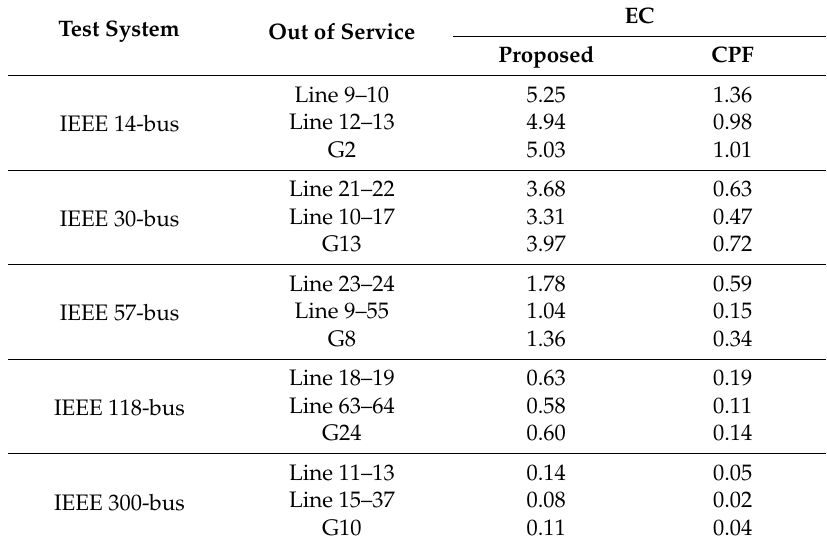
Table 4. Comparison of the results for the considered test systems in topology change